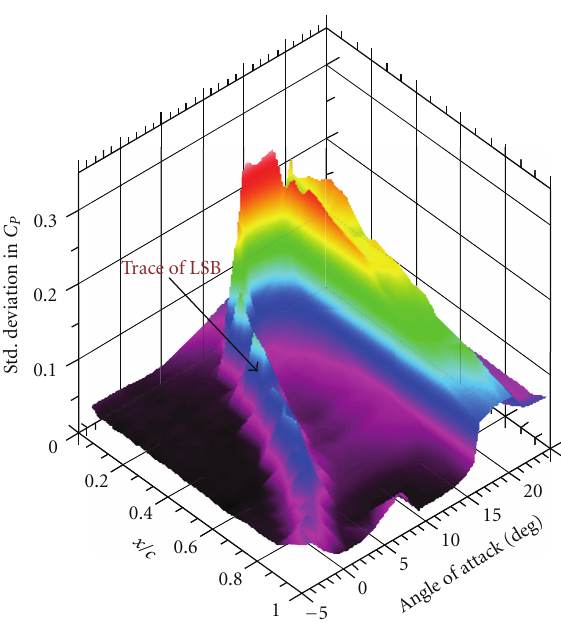
Figure 10: 3D plot of stander. deviation in C P .